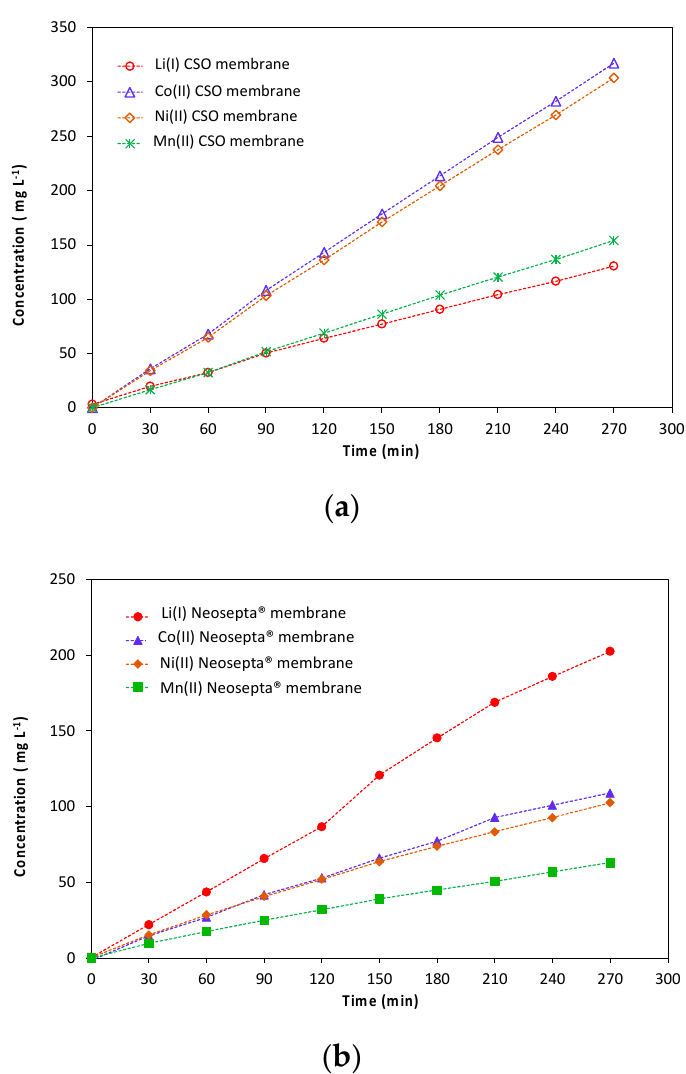
Figure 2. Lithium(I), cobalt(II), nickel(II) and manganese(II) concentrations in the recovery compart- ment as a function of time by using the ED configuration 1 displayed in Figure 1b with ( a ) Selemion CSO cationic exchange membrane, and ( b ) Neosepta ® monovalent-selective cationic exchange mem- brane (j = 12.5 mA cm − 2 ; Flowrate= 100 mL min − 1 in all compartments; Anodic and cathodic solutions: 0.1 M H 2 SO 4 (pH in the leaching solution decreased from 2.8 to 2.1 but it remained almost constant and equal to 1 in the recovery solution).